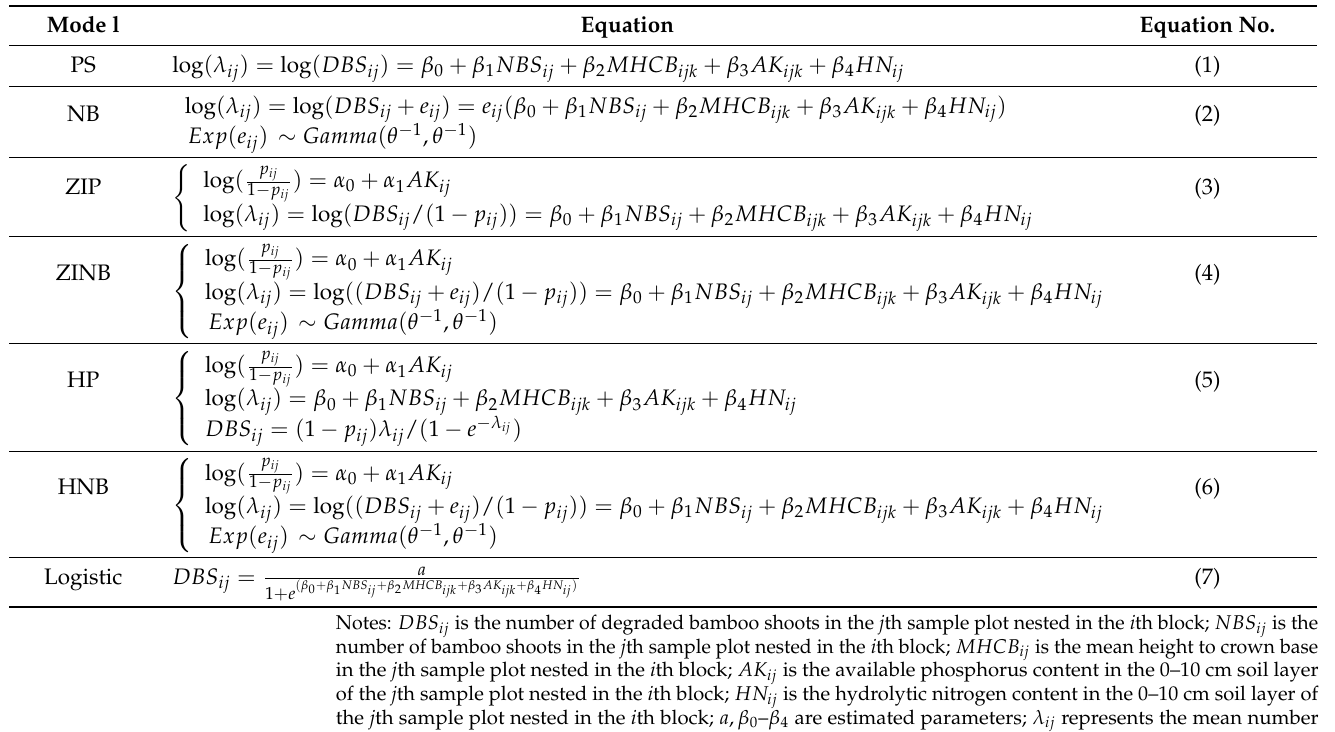
Table 3. Summarized forms of DBS functions, which were expanded through the inclusion of four predictor